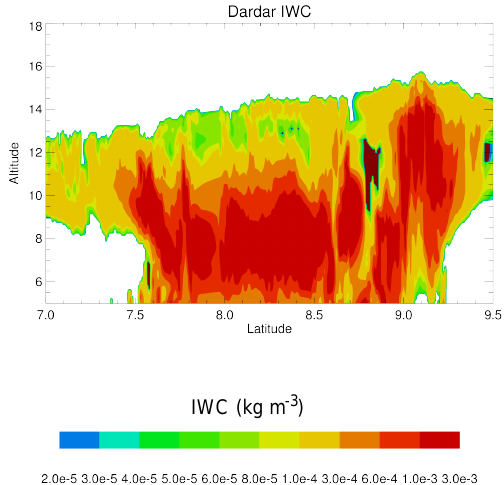
Figure 3. DARDAR IWC structure of a tropical cloudy region ob- served on 10 July 2007.